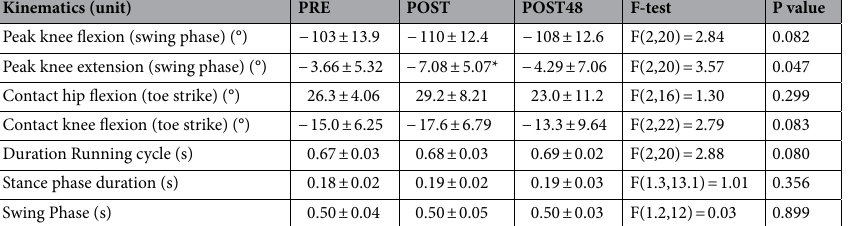
Table 3. Effect of the repeated maximal sprint intervention on kinematics of treadmill running at 4.17 m s −1 . Values are mean ± SD. One-way ANOVA, F- and P-values are reported. Knee fully extended = 0°; negative value indicates a flexed knee. *Different to PRE (P < 0.05).